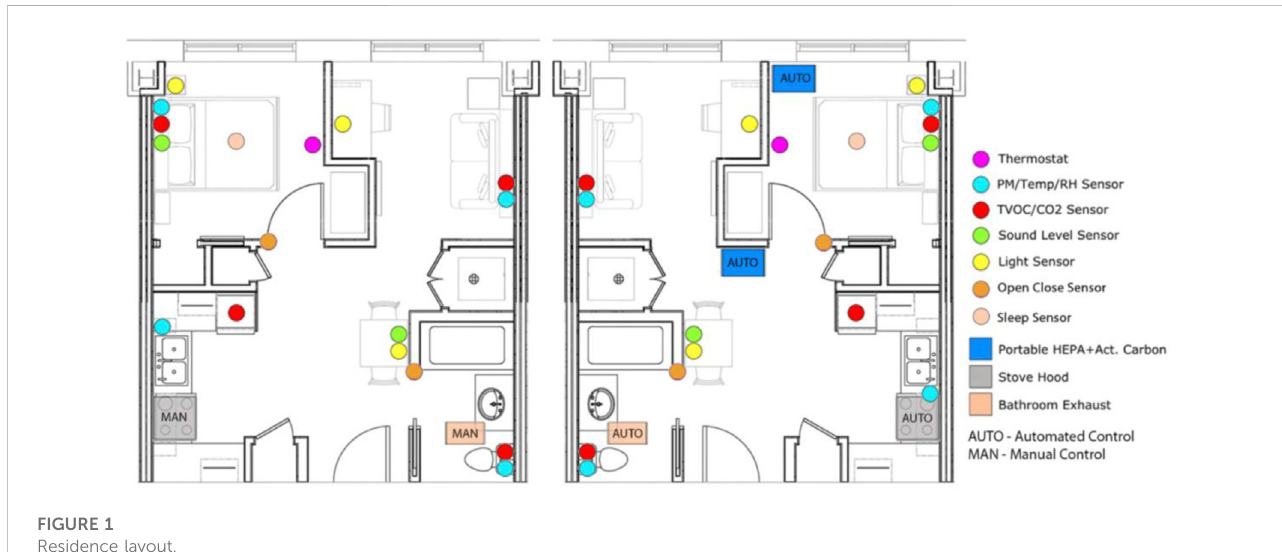
FIGURE 1 Residence